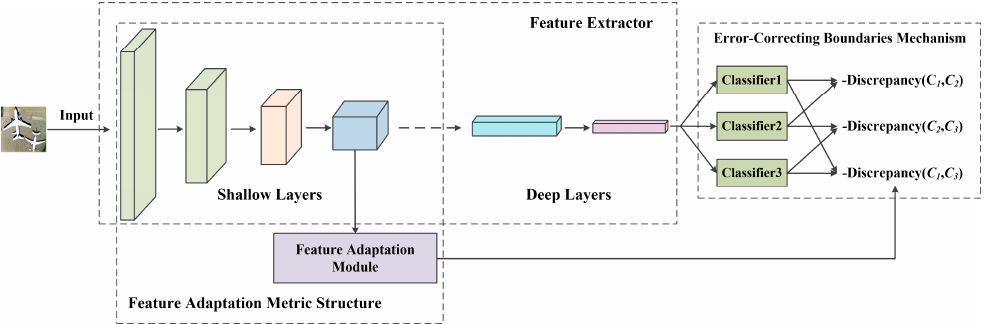
Figure 2. Framework of the error-correcting boundaries mechanism with feature adaptation metric (ECB-FAM) structure.